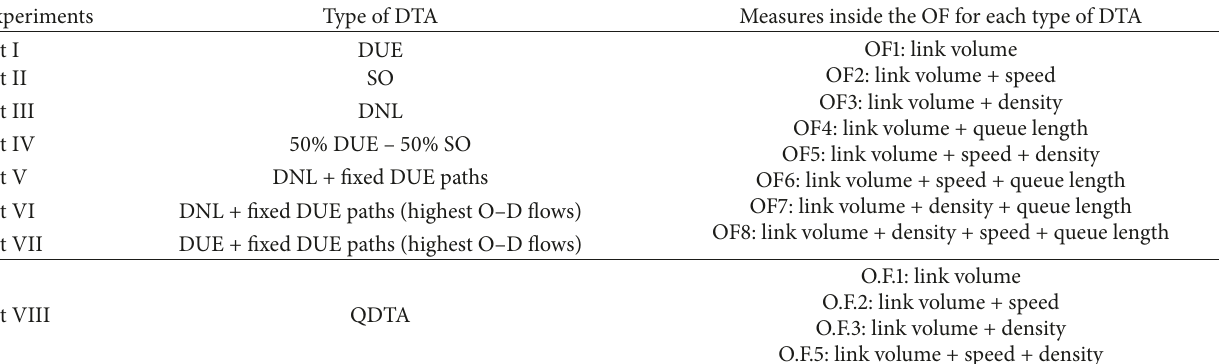
Table 1: Experiment design.